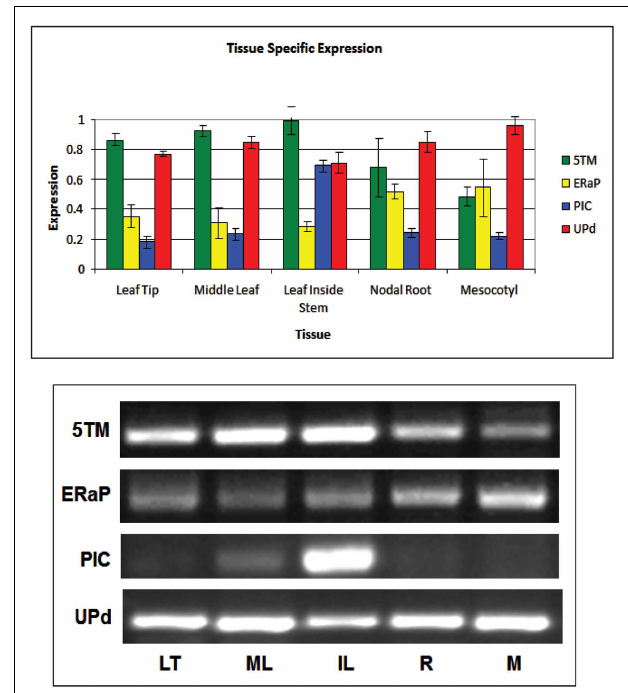
FIGURE 5 | Quantification of semiquantitative RT-PCR showing tissue-specific expression of genes encoding the 5TM protein (green bars), ER-AP (yellow bars), PIC-like protein (blue bars), and UP-d (red bars). Representative gel pictures are shown in the lower half. Band intensities of three to five biological replicates were quantified and displayed in the bar